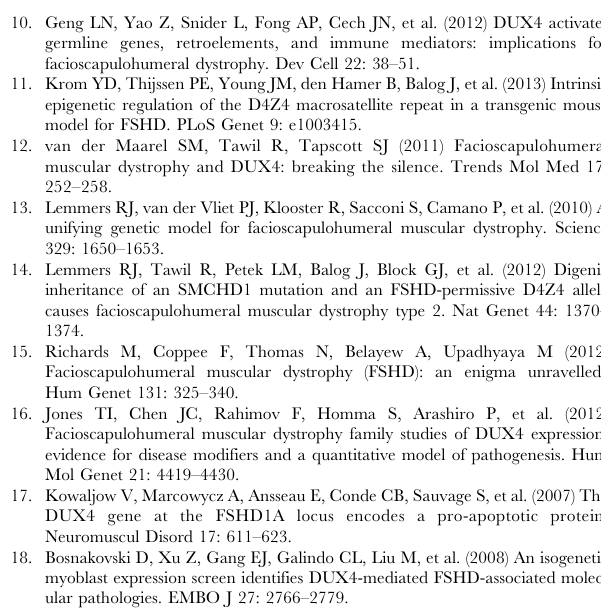
gray, junctions supported by 11–99 reads in orange, and those supported by $ 100 reads in red. Figure S12 Multiple variants of the HSATII repeat are expressed. We aligned HSATII RNA-seq reads to the HSATII consensus sequence (see Methods), and used the IGV browser [87] to display the resulting alignment. In the narrow bottom panel of the display, each nucleotide of the consensus sequence is represented by a colored tick mark (green = A; blue = C; brown = G; red = T). The next two panels from the bottom represent two alignments, each showing RNA-seq data from a different DUX4 -transduced myoblast cell line (upper alignment, MB135 cells, 1,182,329 aligned reads; lower alignment, 54-1 cells, 288,741 aligned reads). In the alignments, each sequence read is shown as a very thin gray line, stacked densely on top of one another. In many regions of the alignment where coverage is very deep, IGV displays only a subset of reads for enhanced visibility. IGV shows positions in each sequence read that do not match the consensus sequence as small colored tick marks, color coded (green = A; blue = C; brown = G; red = T; black = deletion; purple = insertion). It is clear from the number and diversity of non-reference bases among the aligned reads that multiple HSATII variants are transcribed. Table S1 DUX4-binding site locations in the hg19 version of the human genome assembly. The ‘‘repetitive element’’ column shows whether the peak’s best DUX4 motif is in unique sequence, or if not what kind of repetitive element it is in. The last two columns show results from differential expression analysis of the peak plus 1 kb of flanking sequence on each side, comparing expression levels in myoblasts transduced with lentivirus carrying DUX4 to control myoblasts. Table S2 Enrichment estimates for each repeat type among ChIP-seq peaks, ChIP-seq reads and RNA-seq reads. Repeat types are shown sorted by peak-based enrichment estimate. See legend